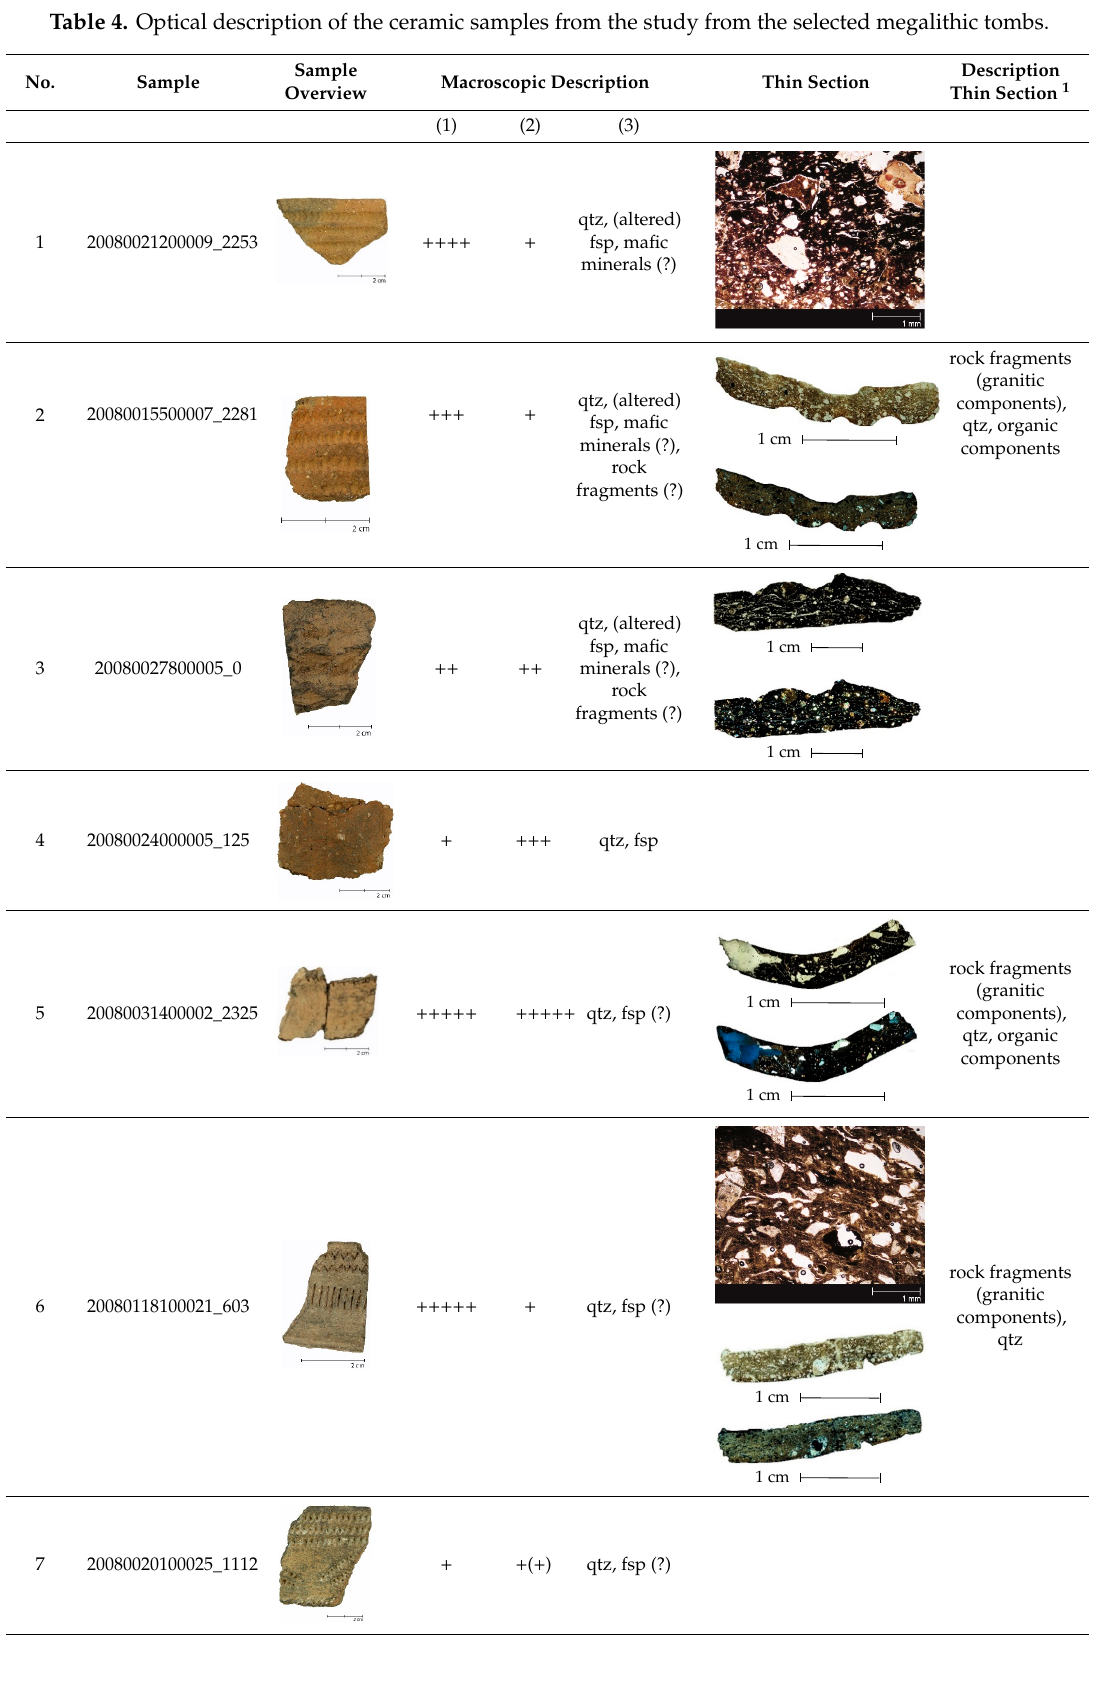
Table 4. Optical description of the ceramic samples from the study from the selected megalithic tombs.